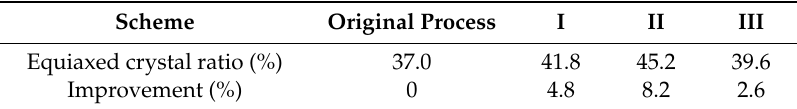
Table 4. Low-power test results under the equiaxed crystal ratios of cast billet samples produced according to different schemes.